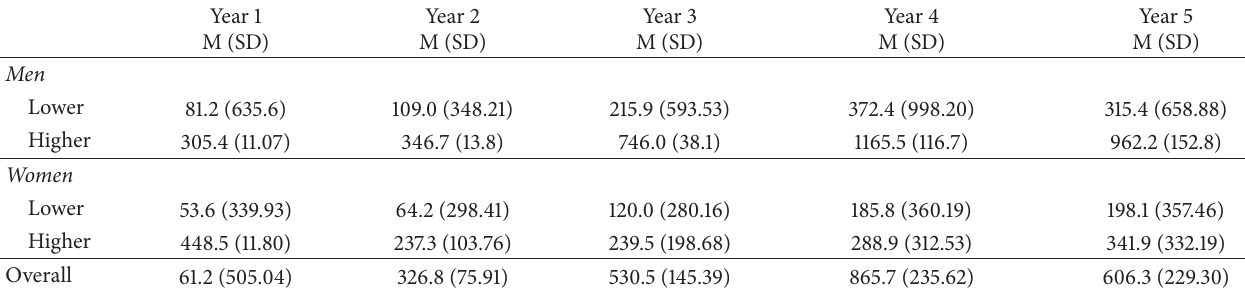
Table 1: Mean (SD) standard drinks for the low and high consumption groups across 5